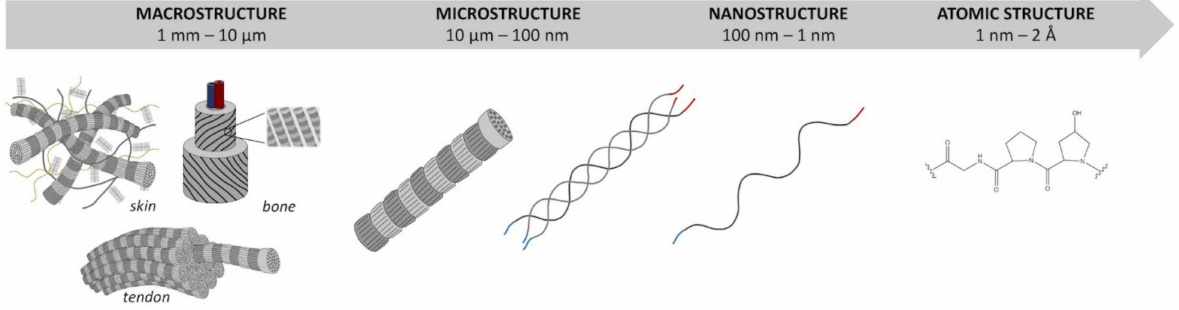
Figure 1. Atomic-scale of type I collagen found in skin, tendon and bones [113]. Reprinted with permission from reference [113]. Copyright 2021 from Frontiers in Bioengineering and